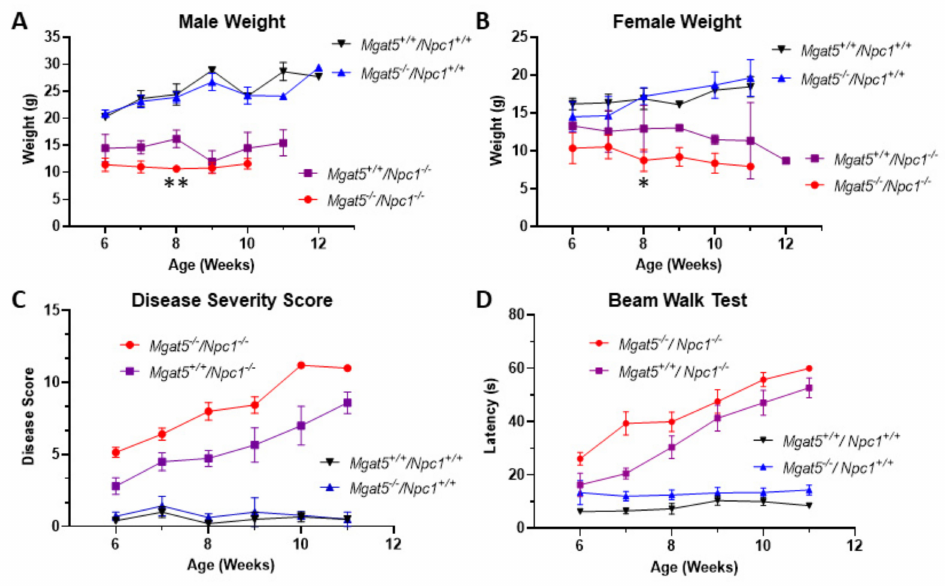
Figure 1. Weight profiles, disease assessment, and beam walk test results of mutant mice. Male ( A ) and female ( B ) mice were weighed weekly starting at week 6 until end-of-life. The weights of Mgat5 +/+ :Npc1 +/+ , Mgat5 − / − :Npc1 +/+ , Mgat5 +/+ :Npc1 − / − , and Mgat5 − / − :Npc1 − / − mice are